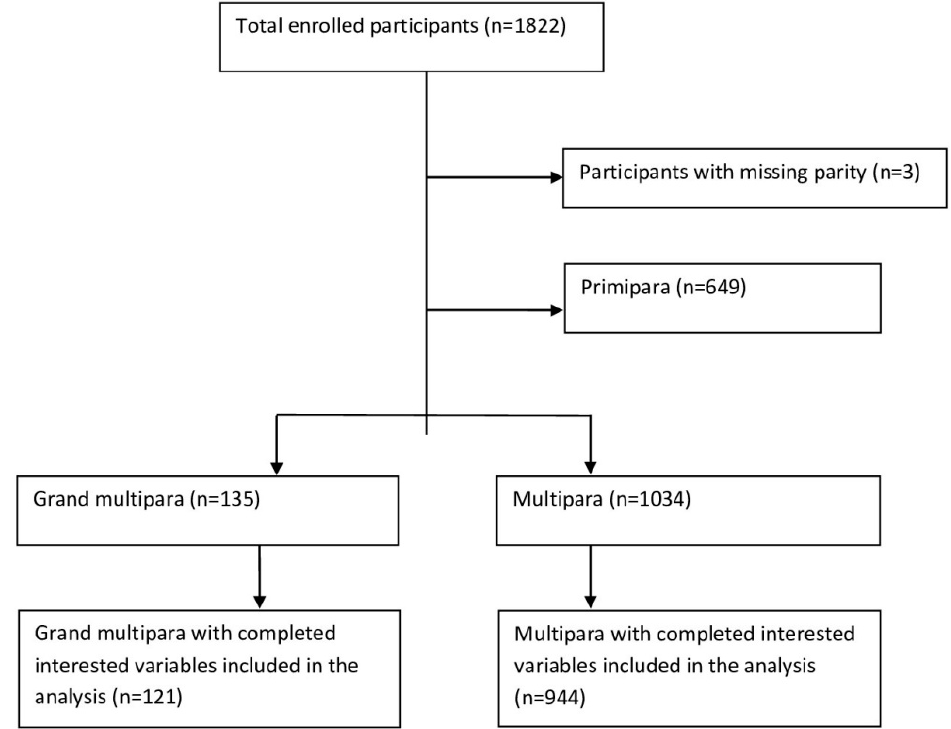
Figure 1. Chart of the selected study